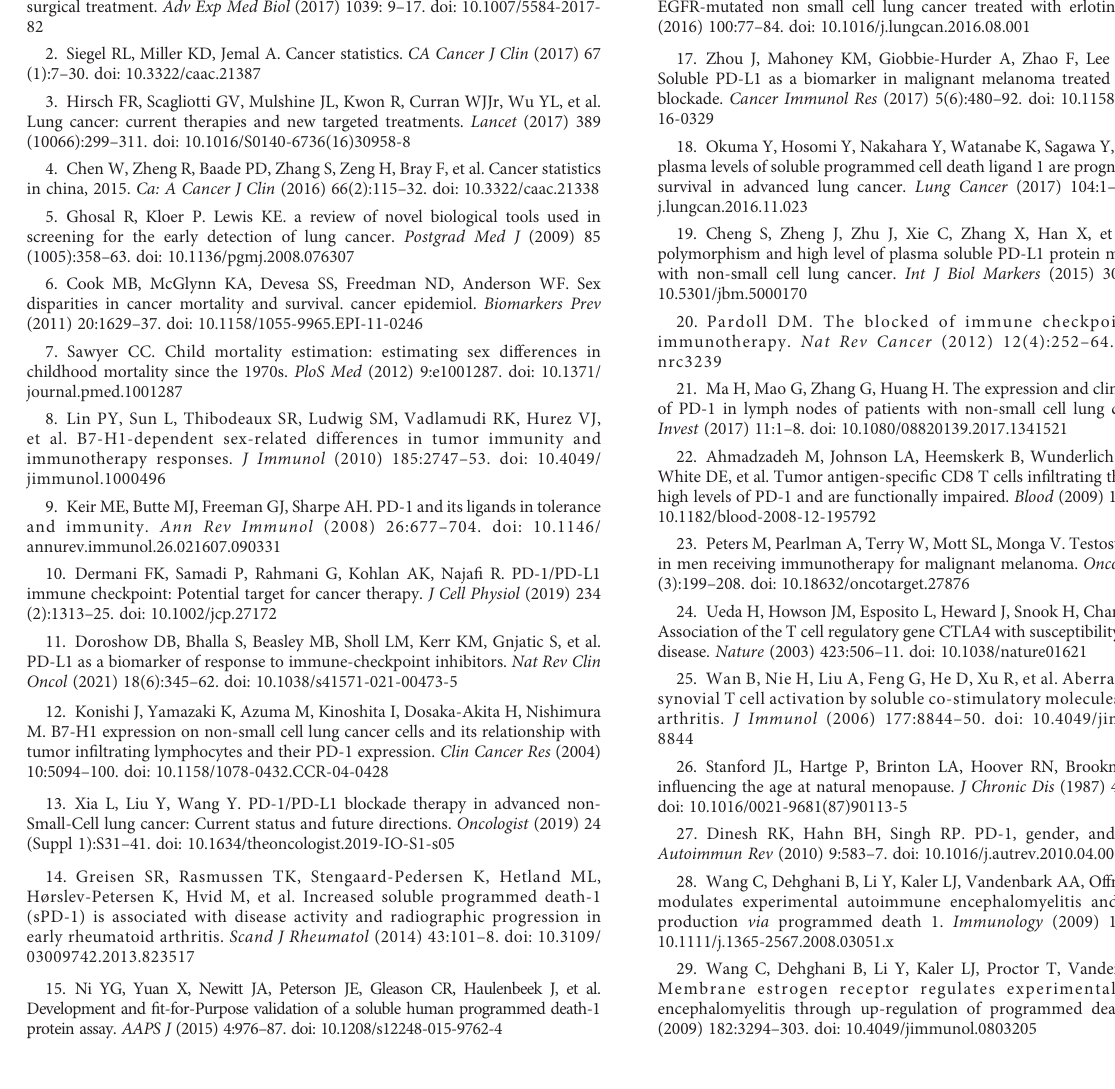
SUPPLEMENTARY FIGURE 4 The percentage of mPD-1+ CD4+/CD8+T cells from healthy control was analyzed by FACS. Peripheral blood mononuclear cells (PBMCs) were treated for 24 h with different concentrations of estrogen (10, 20, and 50 nmol) and androgen (1 and 10 nmol). (A) The frequency of CD8+PD-1+T cells (A) andCD4+PD-1+T cells (B) which weretreated with the ratio of T/ E at 1:50 (1 nmol androgen and 50 nmol estrogen), 1:20 (1 nmol androgen and 20 nmol estrogen), 1:10 (1 nmol androgen and 10 nmol estrogen), 1:5 (1 nmol androgen and 5 nmol estrogen), 1:2 (1 nmol androgen and 2 nmol estrogen), and 1:1 (1 nmol androgen and 1 nmol estrogen) (healthy donor, n = 3). * P < 0.05, Mann – Whitney test (two-tailed) and paired Student t - test. T/E, androgen/estrogen.